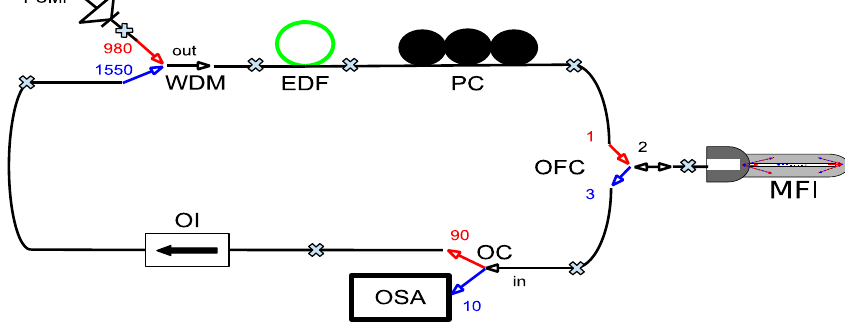
Figure 3. Experimental setup of the ring cavity laser. WDM: wavelength division multiplexer, EDF: erbium-doped fiber, PC: polarization controller, OFC: optical fiber circulator, OC: optical coupler, OSA: optical spectrum analyzer, OI: optical isolator.